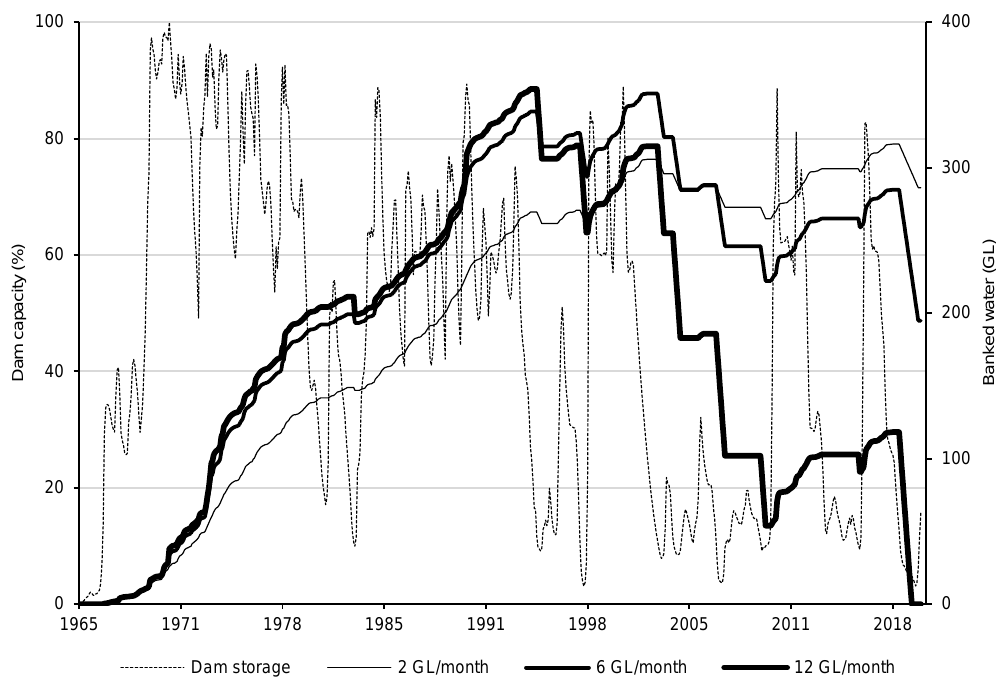
Figure 7. Water banking simulations from 1965 to 2020 for the Macquarie River near Dubbo, showing Burrendong Dam historical storage (a trigger for recharge or recovery) and the residual water in the simulated water bank for three different capacities of recharge and recovery (1 GL = 10 6 m 3 ).